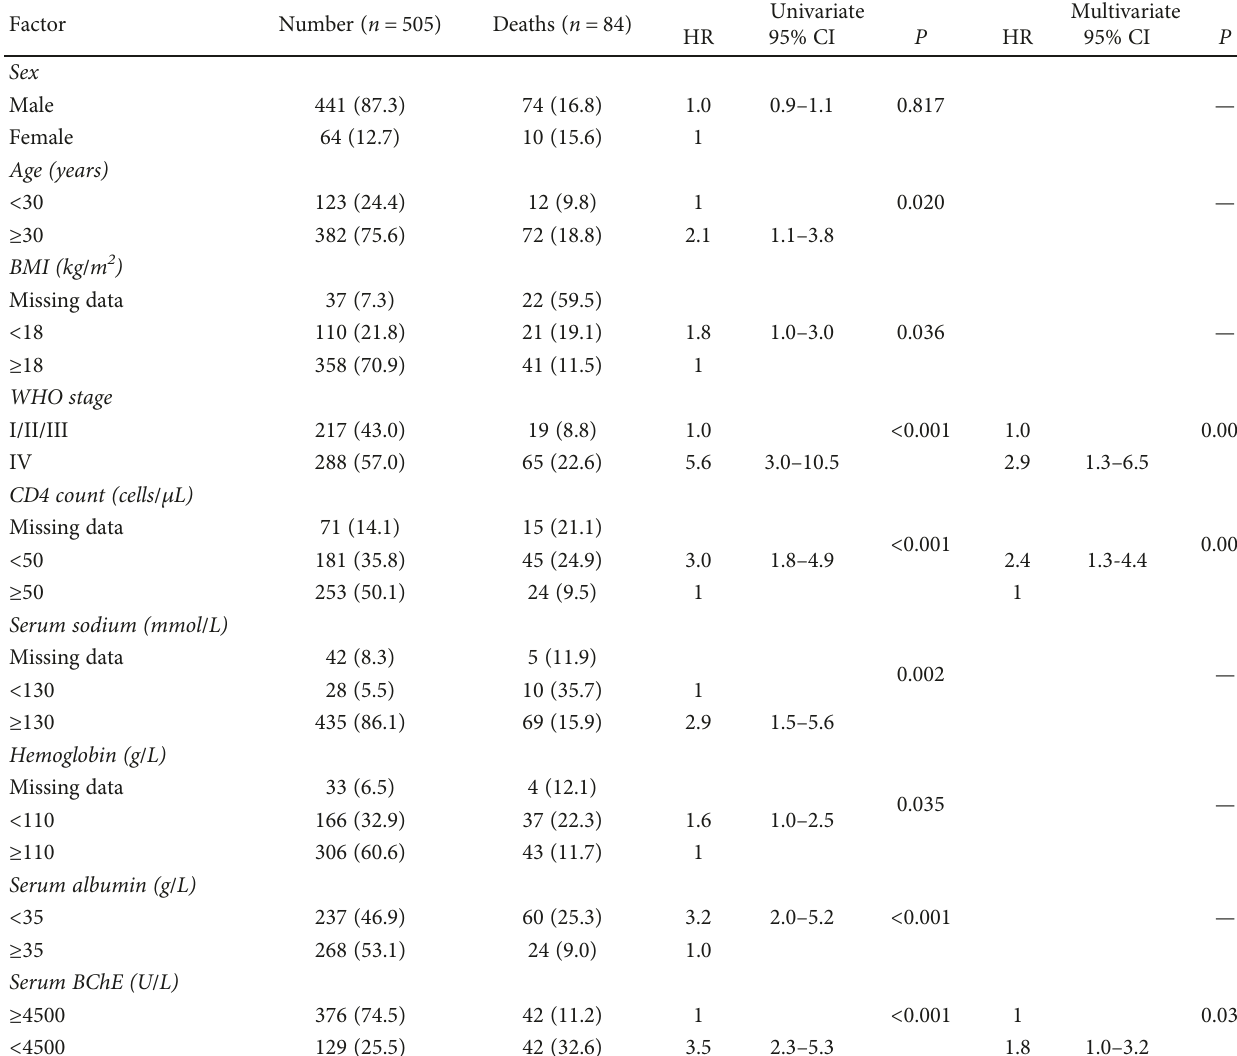
Table 2: Risk factors for mortality of patients in univariate/multivariate Cox proportional hazards